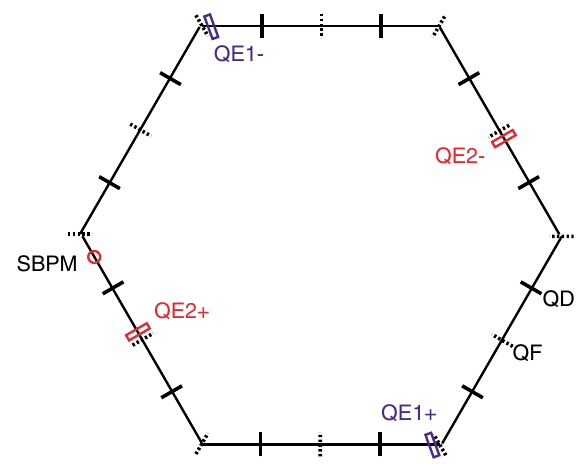
FIG. 8. (Color) Modeled lattice structure used in the numerical simulations.